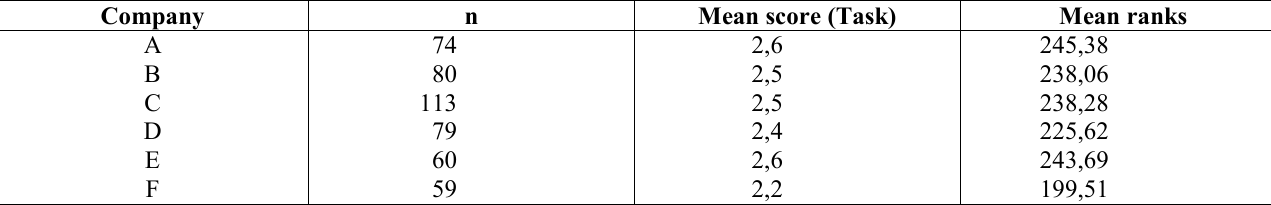
Table 1: Variable: Task oriented/people oriented: company means Company